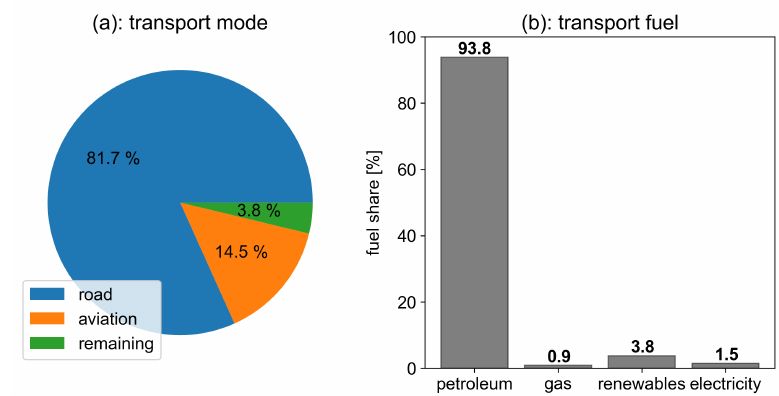
Figure 1. Current status of transport sector in EU countries: ( a ) current energy use for transport by mode; and ( b ) current energy use by fuel. Data used from [19].